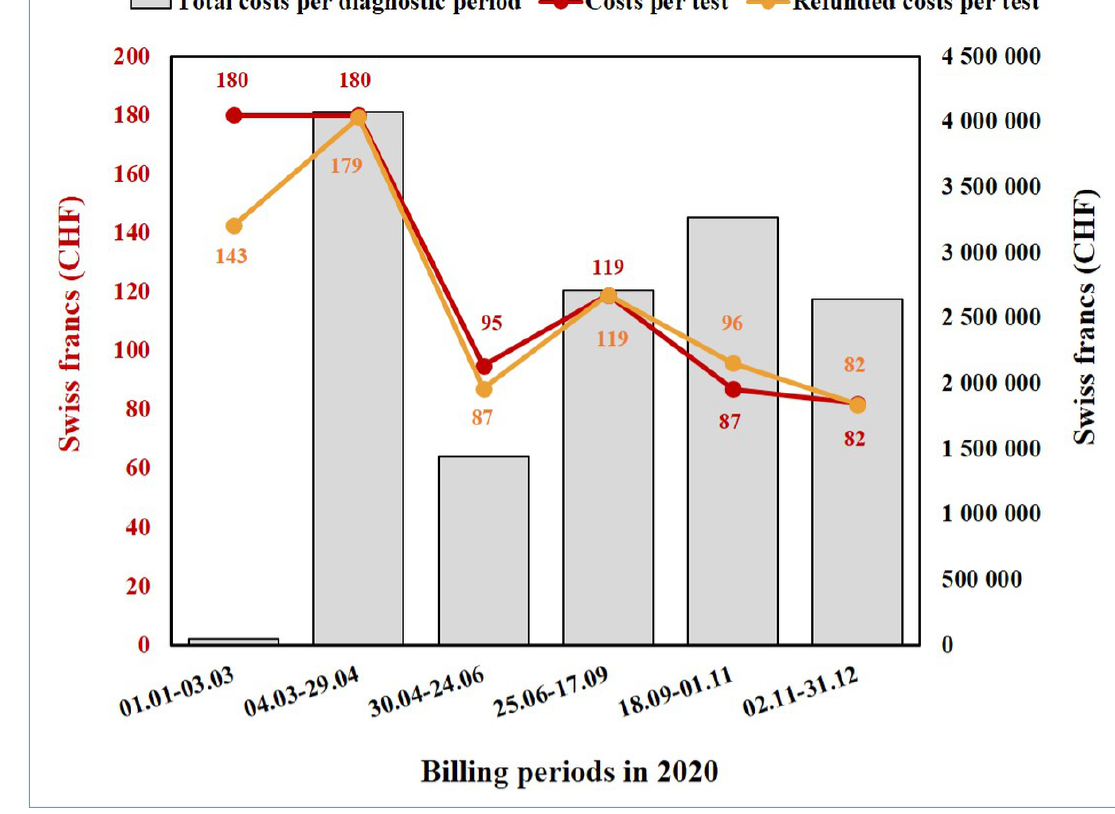
Figure 1: Changes in billing costs per RT-PCR (CHF) and total cumulative costs for all RT-PCRs per billing period throughout 2020 at Lau- sanne University Hospital (Switzerland). Grey columns represent the total amount of money spent for each billing period, based on the total number of SARS-CoV-2 RT-PCR tests performed. Each red dot represents the cost per SARS-CoV-2 RT-PCR test for that precise billing peri- od, while orange dots represent the refunded costs per test for each billing